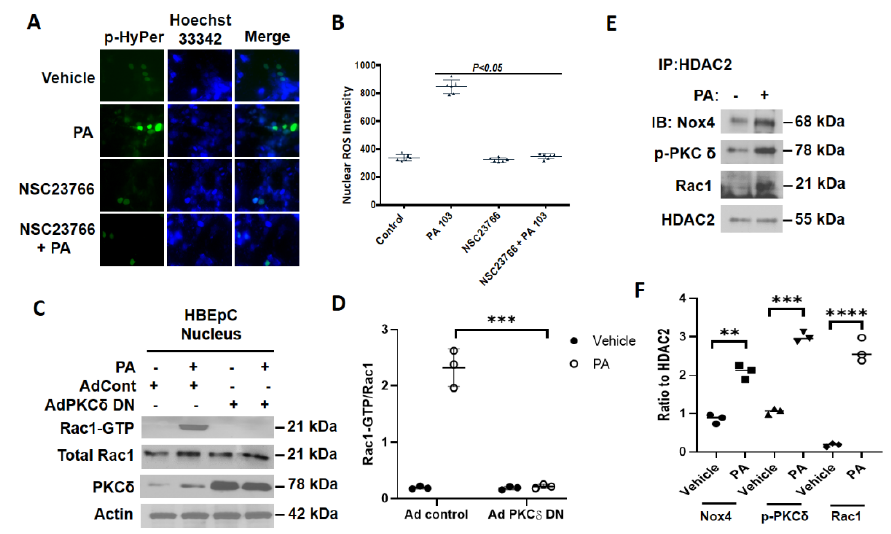
Figure 8. Role of RAC1 in P. aeruginosa -mediated nuclear ROS production and potential interaction between RAC1, PKC δ , NOX4, and HDAC2 in lung epithelial cells. ( A , B ) Primary human bronchial epithelial cells (HBEpCs) cells were transfected with nuclear-HyPer plasmid (50 nM) for 48 h, cells were pretreated with RAC1 inhibitor NSC23766 (5 μ M) for 1 h, followed by heat-inactivated P. aeruginosa ( PA ) (1 × 10 8 CFU/mL) challenge for 3 h. Nuclei were stained in situ with Hoechst 33342. Nuclear ROS (hydrogen peroxide) was imaged by confocal microscopy and quantified by Image J. Value are means ± SD from three independent experiments. p < 0.05. ( C , D ) HBEpCs were infected with vector control or PKC δ -dominant-negative adenovirus (10 MOI) for 48 h prior to exposure to heat-inactivated PA (1 × 10 8 CFU/mL) for 3 h. Nuclei were isolated from vehicle and PA -treated cells as described in Experimental Procedure. The activated RAC1 formed was pulled down from lysates with the p21-activated kinase 1(PAK)-p21-binding domain (PBD) affinity kit described under Methods. Shown is a representative Western blot depicting nuclear RAC1 activation by PA , which was blocked by dominant-negative PKC δ . Total RAC1 and actin served as loading controls. Quantification of activated RAC1 was performed by the Image J program. Values are means ± SD from three independent experiments. *** p < 0.005. ( E , F ) HBEpCs were challenged with vehicle or PA (1 × 10 8 CFU/mL) for 3 h. Nuclei were isolated as described in Experimental Procedure and nuclear lysates (~500 μ g protein) were subjected to immunoprecipitation with anti-HDAC2 antibody. The immunoprecipitates were subjected to SDS-PAGE and Western blot analysis with anti-HDAC2, anti-NOX4, anti-RAC1, and anti-PKC δ antibodies to detect interaction of HDAC2 with NOX4, PKC δ , and RAC1. Shown is a representative blot, and values are means ± SD from three independent experiments. ** p < 0.01, *** p < 0.005, **** p < 0.001.